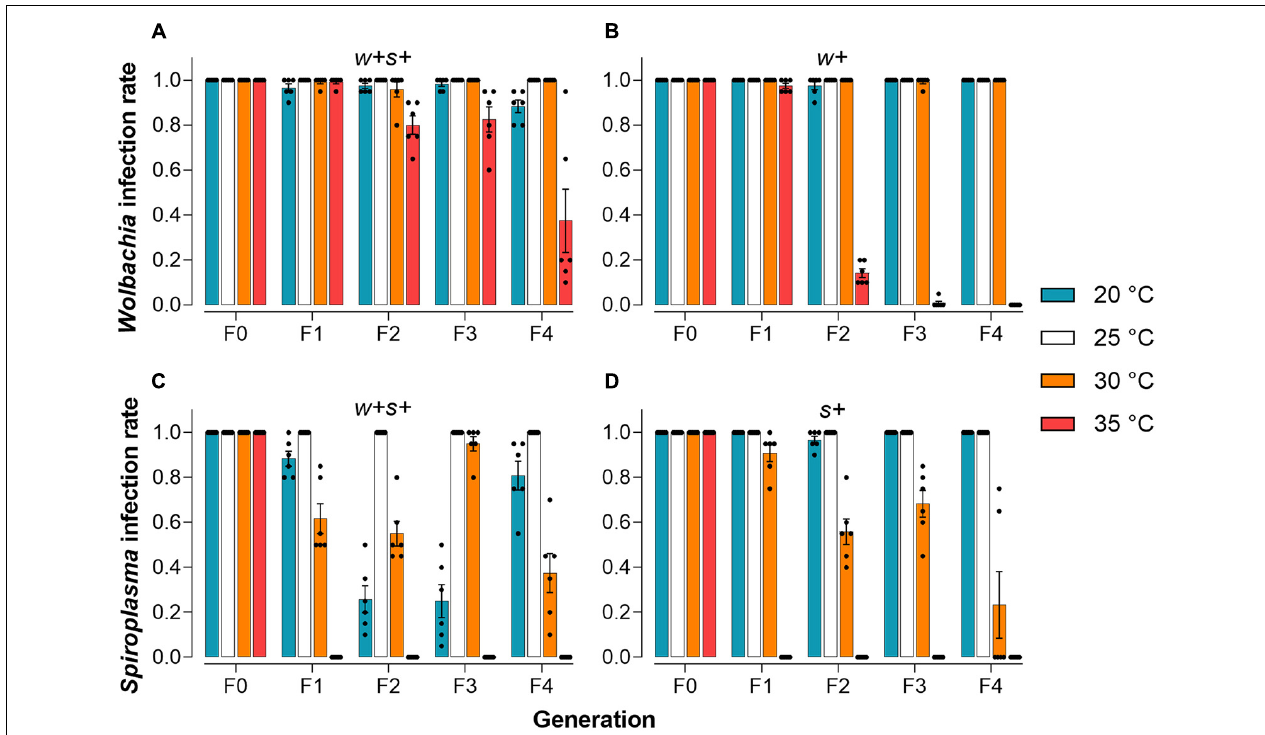
FIGURE 4 | Infection frequencies of two endosymbionts in female adult spider mites reared for four generations under different temperature conditions. Infection rate of Wolbachia in co-infected strains (A) and Wolbachia -infected strains (B) . Infection rate of Spiroplasma in co-infected strains (C) and Spiroplasma -infected strains (D)